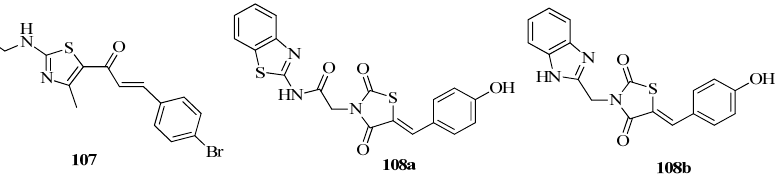
Figure 43. Structures of (E)-3-(4-bromophenyl)-1-(2-(ethylamino)-4-methylthiazol-5-yl)prop-2-en-1-one ( 107 ) and thiazolidine-2,4-dione/benzazole derivatives ( 108 ). Hidalgo-Figueroa et al. [161] designed and synthesized two thiazolidine-2,4-dione/ benzazole derivatives ( 108a , 108b ) as PTP1B inhibitors (Figure 43). The compounds